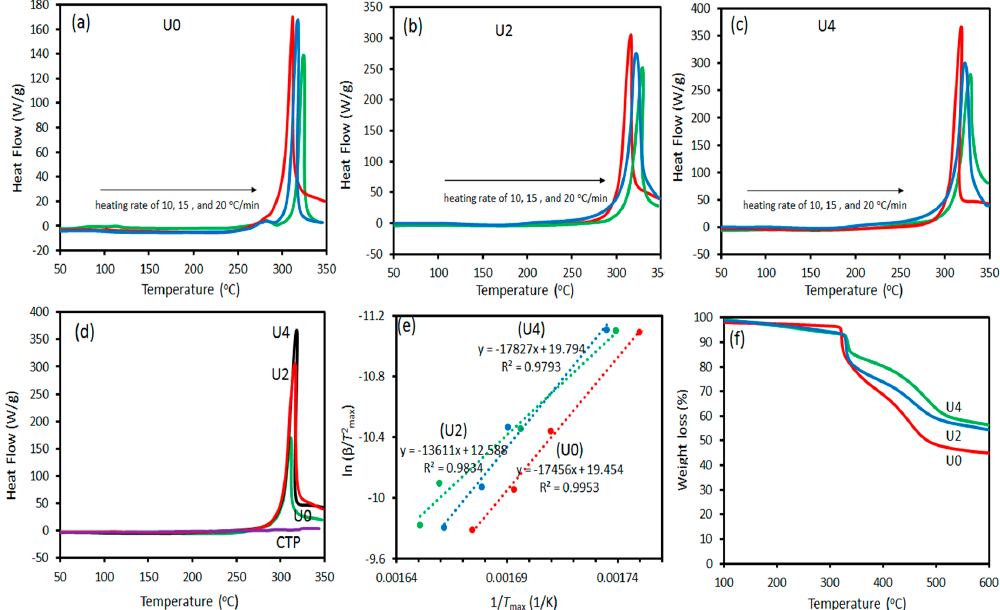
Figure 4. Di ff erential scanning calorimetry (DSC) thermograms at various heating rates for ( a ) U0, Figure 4. Differential scanning calorimetry (DSC) thermograms at various heating rates for ( a ) U0, ( b ) U2 and ( c ) U4, respectively; noting the change in scale of the Y-axis. Comparison of DSC thermograms ( b ) U2 and ( c ) U4, respectively; noting the change in scale of the Y-axis. Comparison of DSC at a heating rate of 10 °C/min ( d ), Kissinger plots for obtaining the activation energy of thermal thermograms at a heating rate of 10 ◦ C / min ( d ), Kissinger plots for obtaining the activation energy of stabilisation process ( e ), and TGA thermograms of various samples ( f ). thermal stabilisation process ( e ), and TGA thermograms of various samples ( f ). Figure 4. Differential scanning calorimetry (DSC) thermograms at various heating rates for ( a ) U0, ( b ) Table 2. Thermal characteristics of various samples obtained by DSC and thermogravimetry analyses (TGA). Table 2. Thermal characteristics of various samples obtained by DSC and thermogravimetry analyses (TGA). U2 and ( c ) U4, respectively; noting the change in scale of the Y-axis. Comparison of DSC thermograms at a heating rate of 10 °C/min ( d ), Kissinger plots for obtaining the activation energy of thermal Sample stabilisation process ( e ), and TGA thermograms of various samples ( f ). Table 2. Thermal characteristics of various samples obtained by DSC and thermogravimetry analyses (TGA).